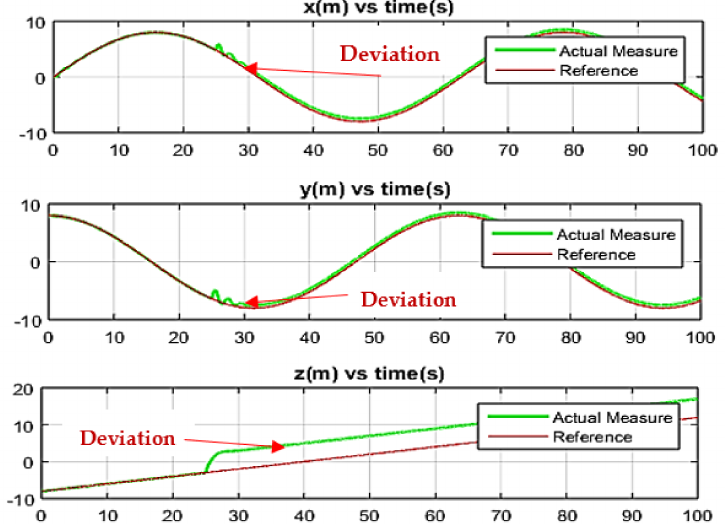
Figure 7. Helical trajectory tracking using Backstepping control under unmodelled dynamics and external disturbance.